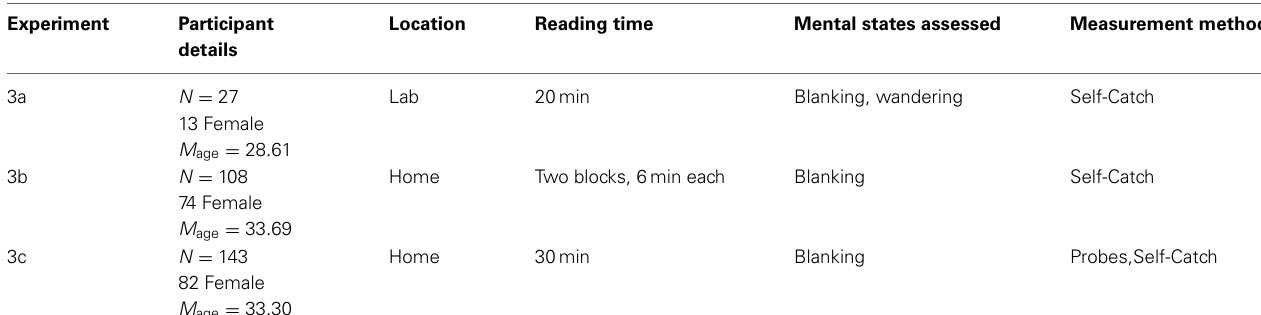
Table 4 | Experimental design of Experiments 3a, 3b, and 3c.